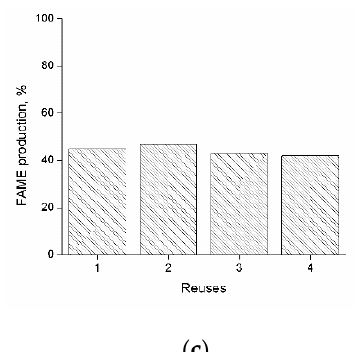
Figure 11. Reuse of the SiO 2 @ZrO 2 -CaO for FAME production: ( a ) SiO 2 @ZrO 2 0.08 M–CaO, ( b ) SiO 2 @ZrO 2 0.08 M–CaO, and ( c ) SiO 2 @ZrO 2 0.04M–CaO.